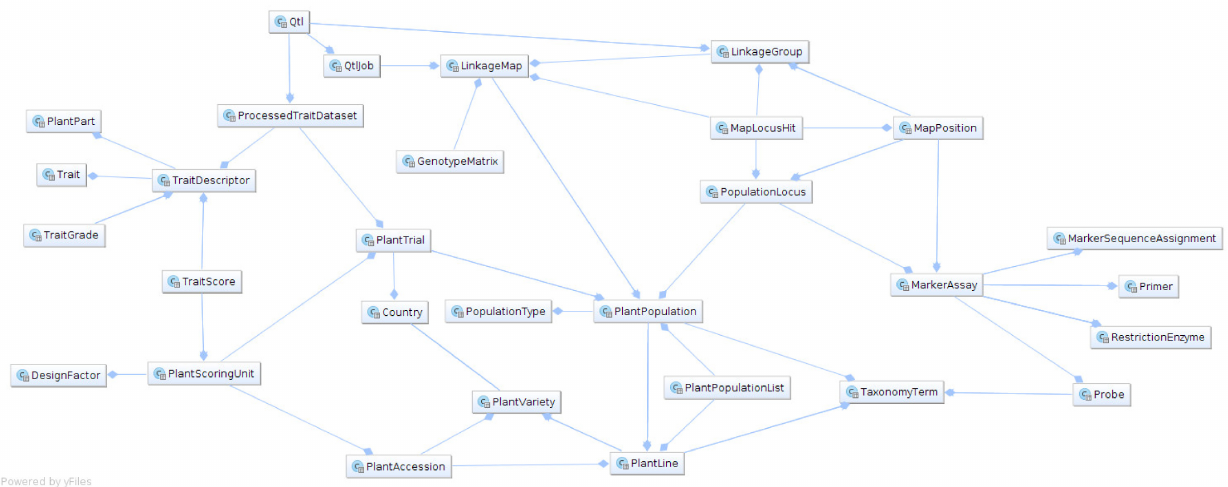
Figure 1. BIP database model. The diagram provides an overview on all tables in the BIP database, and the relations between them. Some “operational” tables, which are used only internally by the system (e.g. for access rights), were omitted.